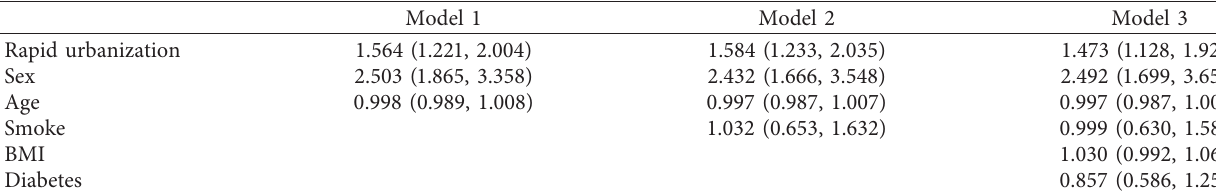
Table 2: Logistic regression analysis for risk factors of TPOAb positivity.